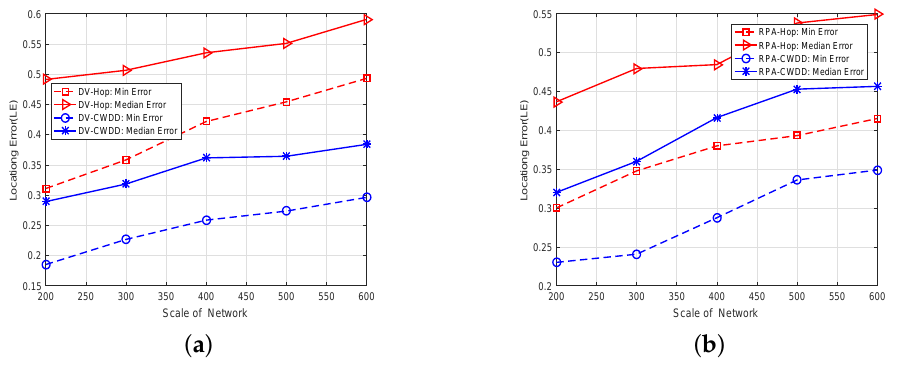
Figure 10. Different system scales: ( a ) Dv-based, ( b )